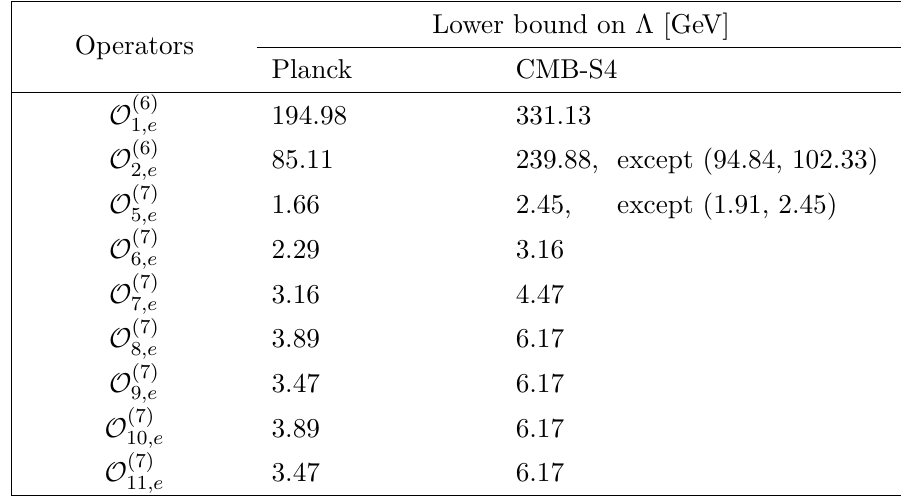
Table 3 . Constraints on EFT operators from current Planck data and future CMB-S4 proposal. All lower bounds are obtained by assuming one non-vanishing EFT operator at a time and fixing the Wilson coefficients at unity. Note that for O (6) CMB-S4 as a result of destructive interference or a negative shift in N See the main text for more